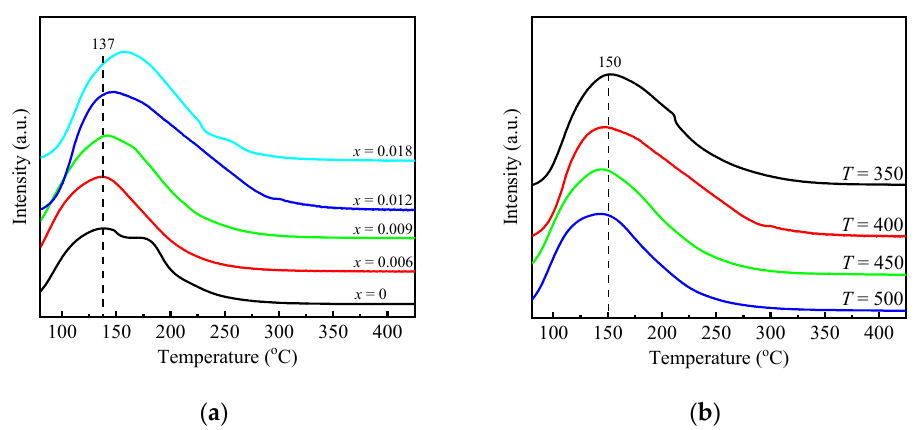
Figure 3. NH 3 -TPD patterns of ( a ) AlP 1.1 Zr x -400 and ( b ) AlP 1.1 Zr 0.012 - T samples.